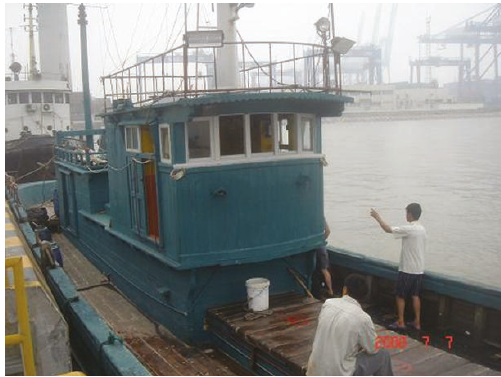
Figure 7: The wood-dominant ship for geomagnetic